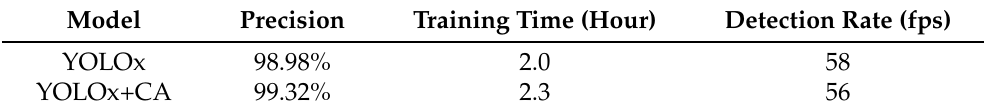
Table 1. Comparison of original YOLOx and improved